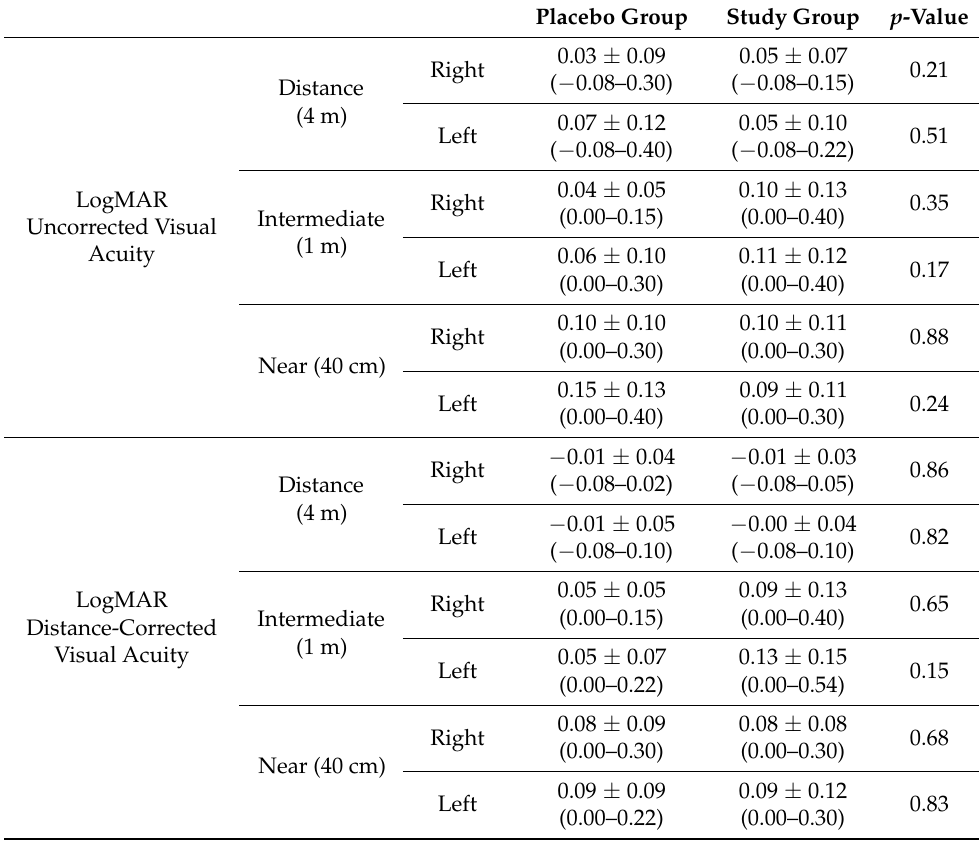
Table 1. Monocular VA characteristics of both groups before the training. Mean ± standard deviation (minimum and maximum) values for distance, intermediate, and near vision are represented by groups for right and left eyes. Differences between groups were assessed by a Mann–Whitney test, and statistically significant differences ( p < 0.05) are marked with an asterisk (*). Distance, intermediate, and near vision were assessed at 4 m, 1 m, and 40 cm, respectively. Placebo Group Study Group p